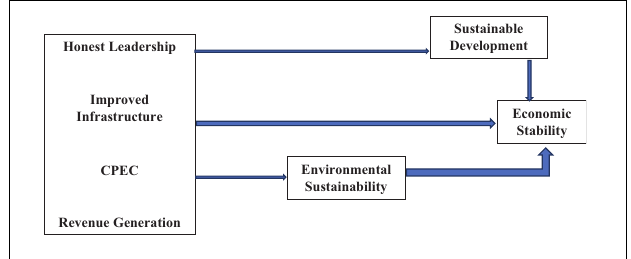
FIGURE 1 | Theoretical model.